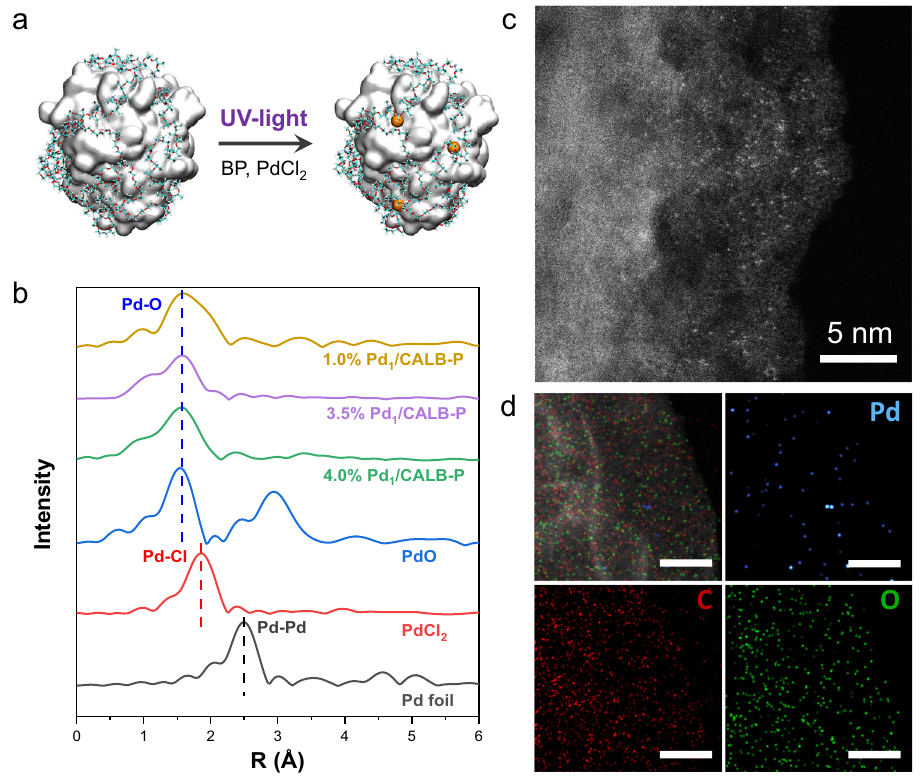
Fig. 1 Preparation and characterizations of Pd1/CALB-P. a Synthesis of Pd-anchored enzyme. b Pd K-edge EXAFS in R space for Pd 1 /CALB-P. PdO, PdCl 2 , and Pd foil were used as references. c Magni fi ed AC-STEM image of Pd 1 /CALB-P in which the bright dots represent Pd single atoms. d AC-STEM image of Pd 1 /CALB-P and the corresponding elemental mapping for Pd, C, and O. Scale bars: 50